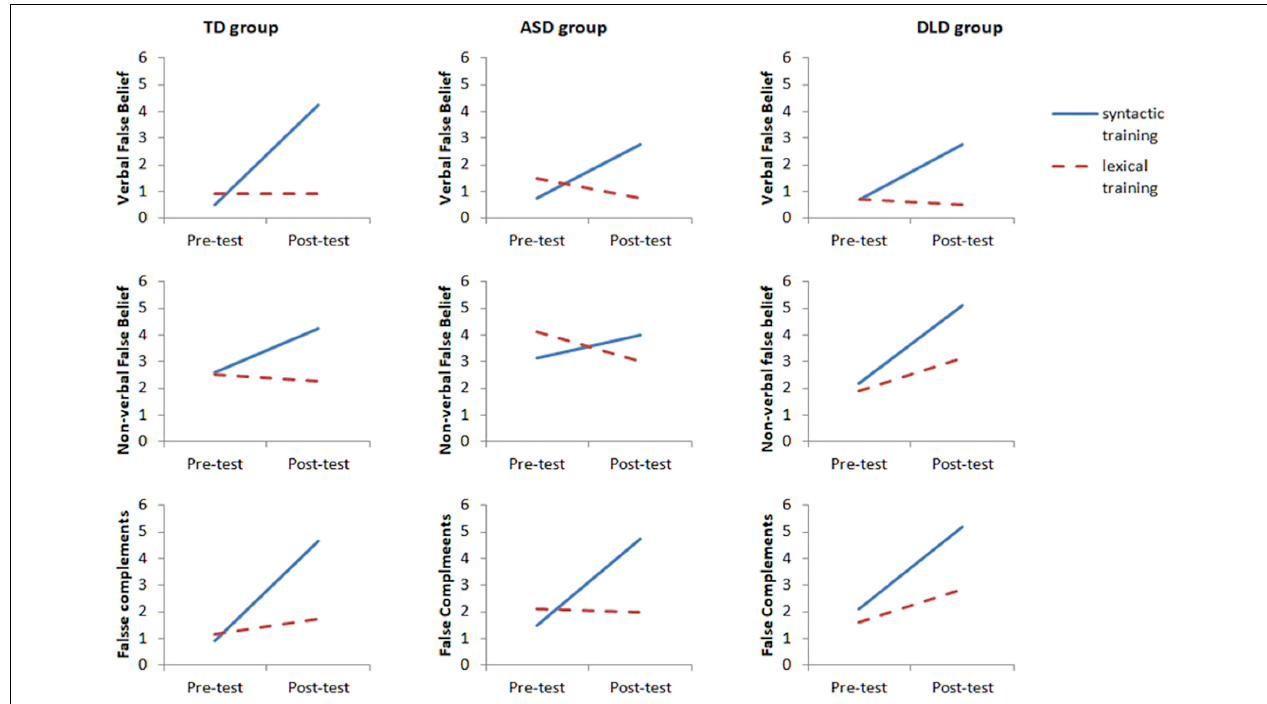
FIGURE 6 | Interaction between training (syntax vs. lexicon) and moment of test (pre-test vs. post-test) on verbal false belief, low-verbal false belief and false complements for the three populations of children (TD, Typically Developing; ASD, Autism Spectrum Disorder; DLD, Developmental Language